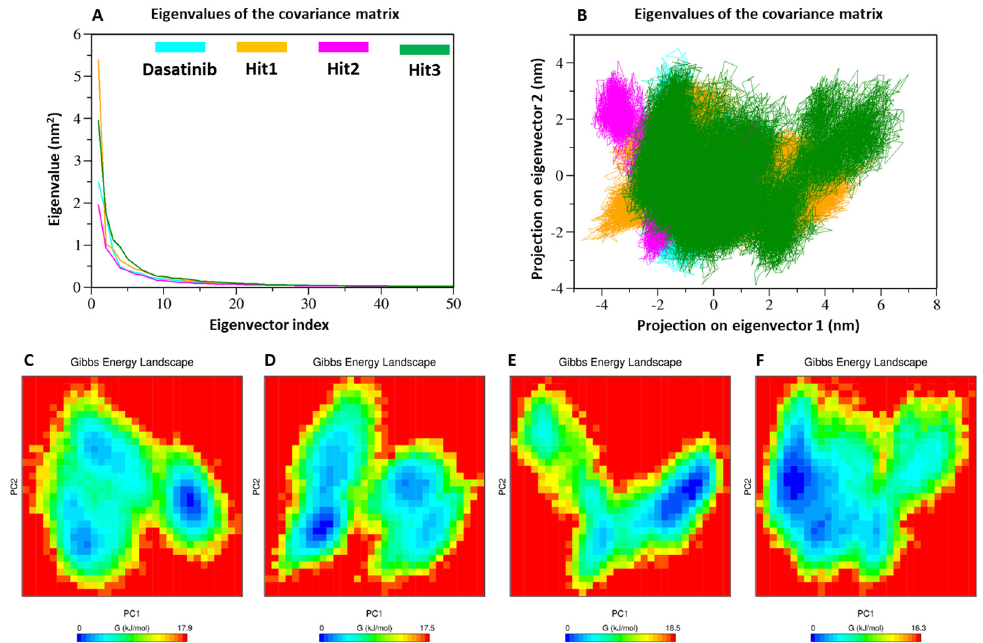
Figure 10. PCA analyses. ( A ) Eigenvector index, ( B ) PC1 and PC2, and ( C – F ) free energy landscape of REF, Hit1, Hit2, and Hit3, respectively. The blue spot in the plots indicates the energy minima, whereas the red color indicates a higher energy conformation.